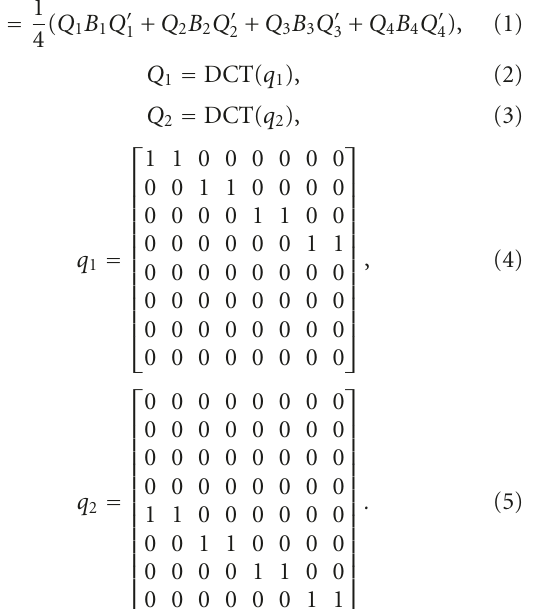
4 × 4 pixels in the top left corner; and the rest of the block is padded with zeros. At the second stage, the adjacent blocks are shifted according to the location of the underlying block b i . That is, the 4 × 4 pixels are shifted to the top left corner in b 1 and to the top right in b 2 and so forth. Finally, the four new blocks are added and divided by four to generate the down-sampled block b . These steps are formulated by (1). In the figure, Q 1 and Q 2 are defined by (2) and (3). However, Q (cid:2) and Q (cid:2) indicate the transpose of Q 1 and Q 2 , while q 1 and q 2 2 are defined by two matrices, as formulated in (4) and